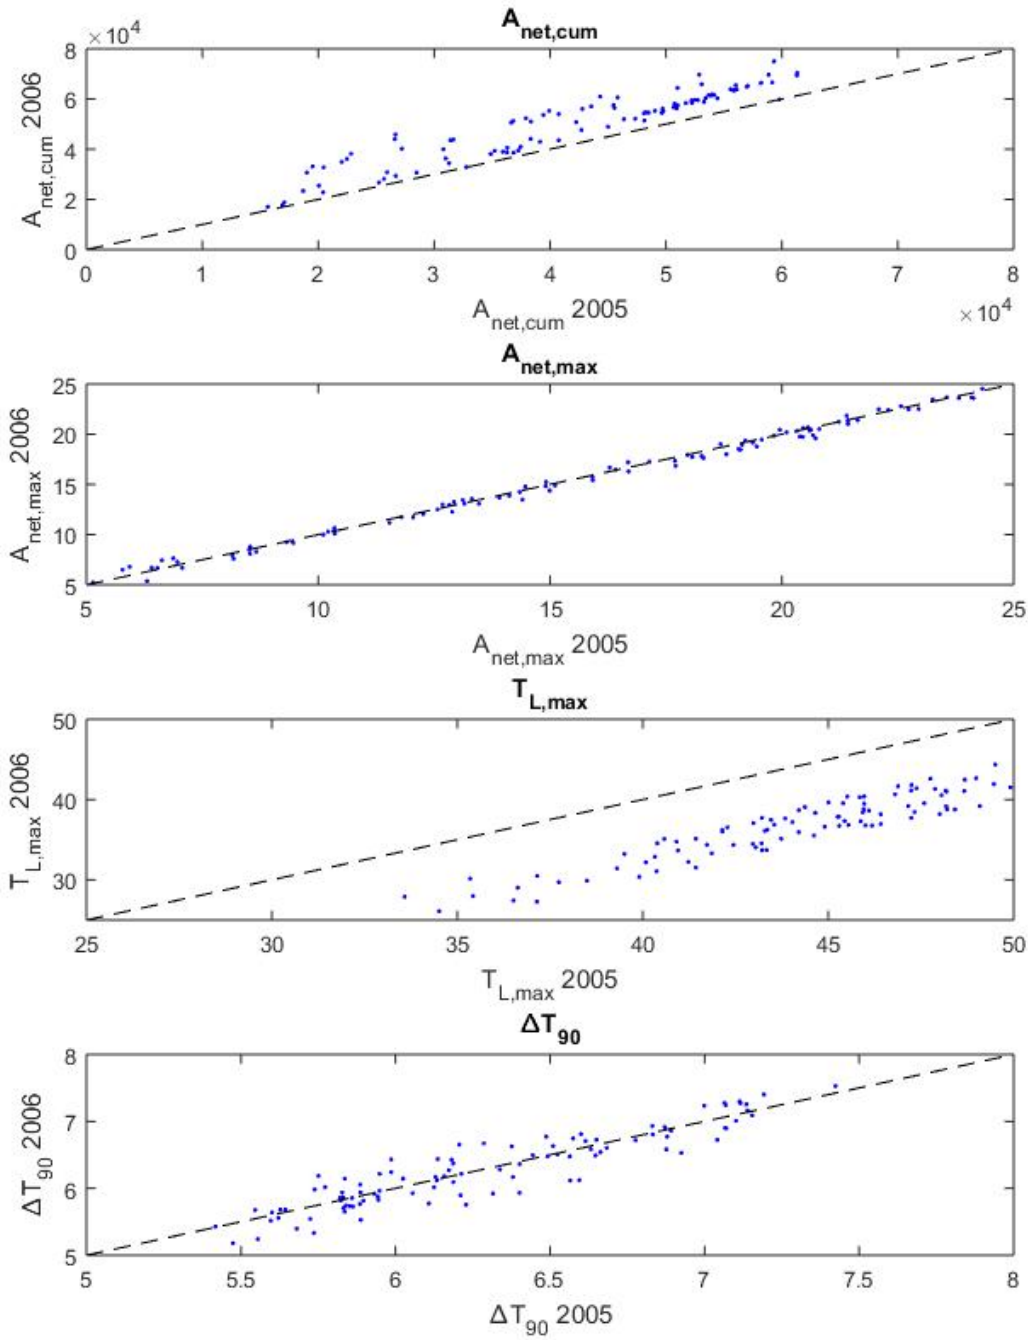
Figure 2. Comparison of model outputs for 2005 and 2006. Value of the four metrics A net,cum (in µ mol m –2 ), A net,max (in µ mol m –2 s –1 ), T L,max and ∆ T 90 (in ◦ C) obtained for the 100 combination of traits under the growing conditions 2005 and 2006. The dashed line corresponds to the 1:1